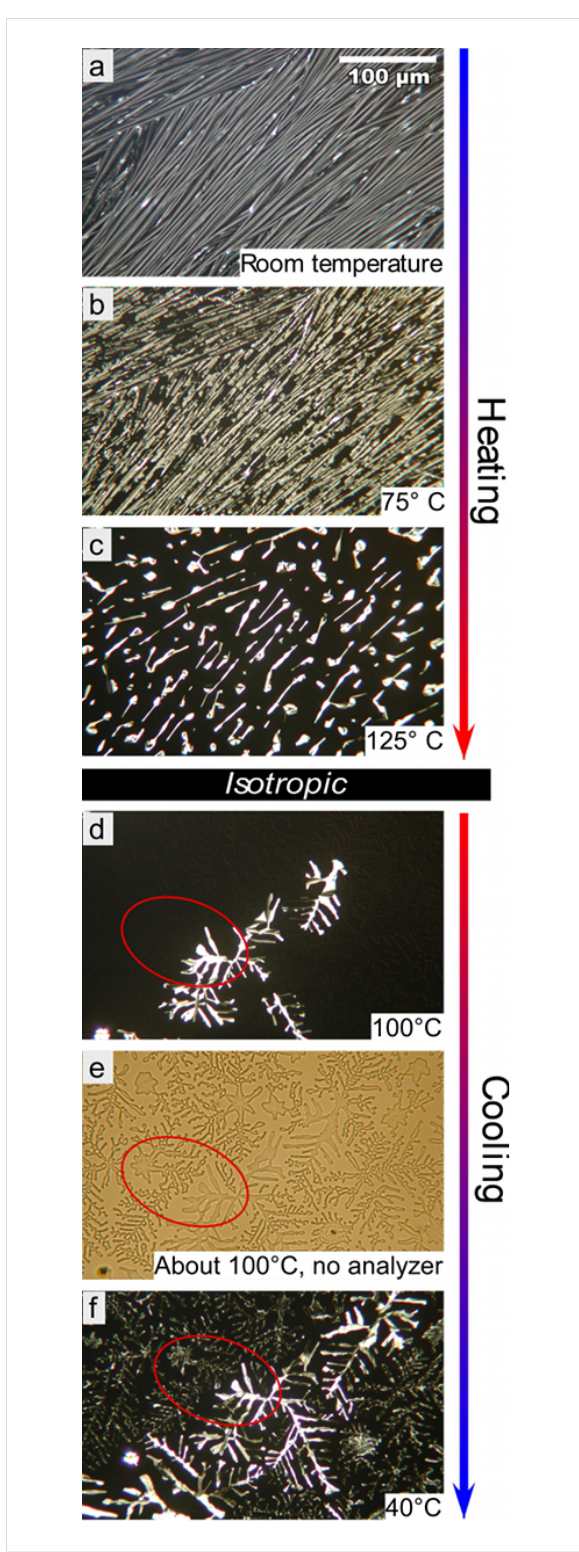
Figure 1: Optical microscopy textures of a film prepared by drop- casting on heating to the isotropic phase and subsequent cooling. All images were taken with crossed polarizers, except (e) which was taken with the analyzer